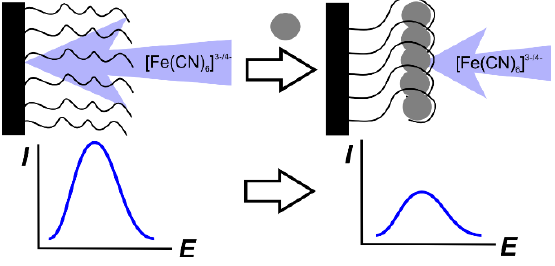
Figure 9. Principal scheme of the label-free measurement of the aptasensor signal.